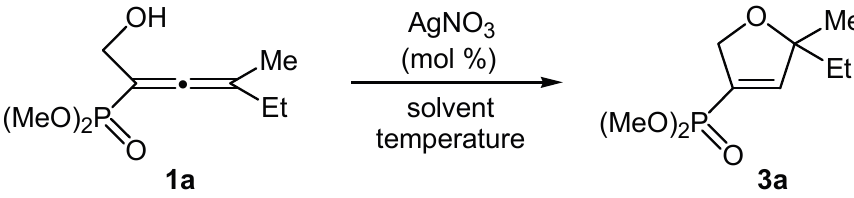
Scheme 1. AgNO 3 -catalyzed cycloisomerization of the model dimethyl 1-hydroxymethyl-